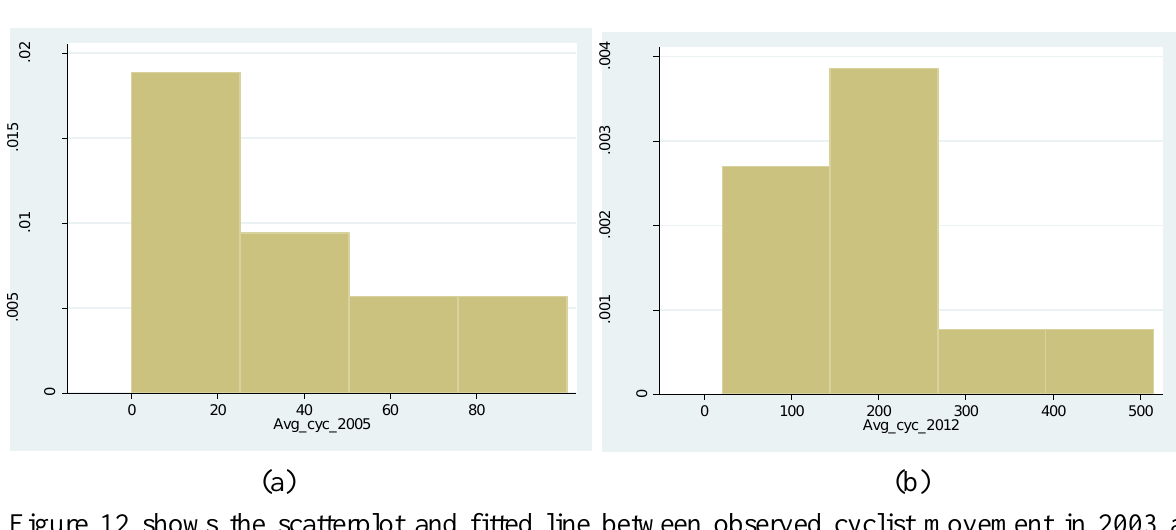
Figure 11. ( a ) Histogram depicting average all-day hourly cyclist movement distribution for the case study area in 2003 ( left) ; ( b ) Histogram depicting average all-day hourly cyclist movement distribution for the case study area in 2012 ( right ).